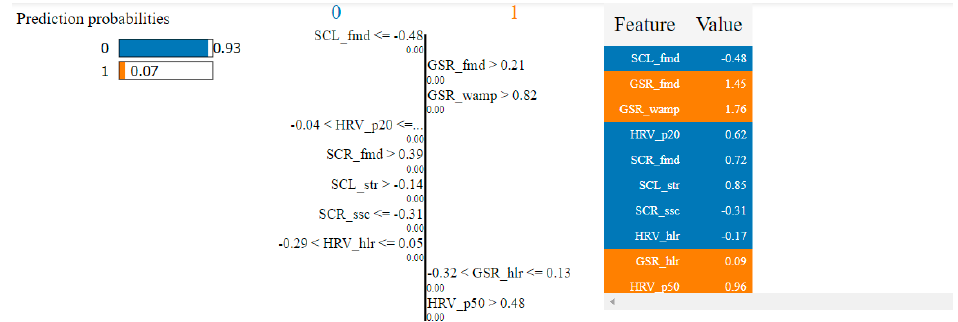
Figure 27. Prediction features for situation 0 (no fear), for the overlapping dataset.